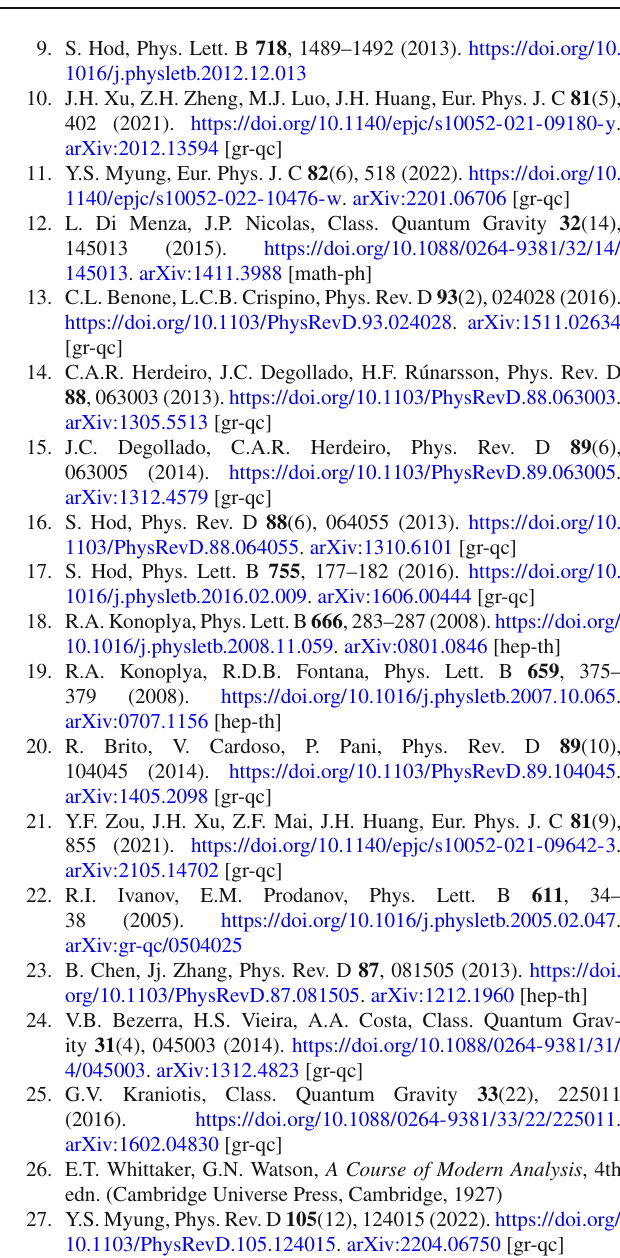
a local minimum (maximum) far from the outer horizon. qQ m denotes the quantization condition and ω < ω c represents the superradiance condition. Finally, q > μ may be a necessary condition for superra- diant instability when a cavity is placed around the dRN black hole